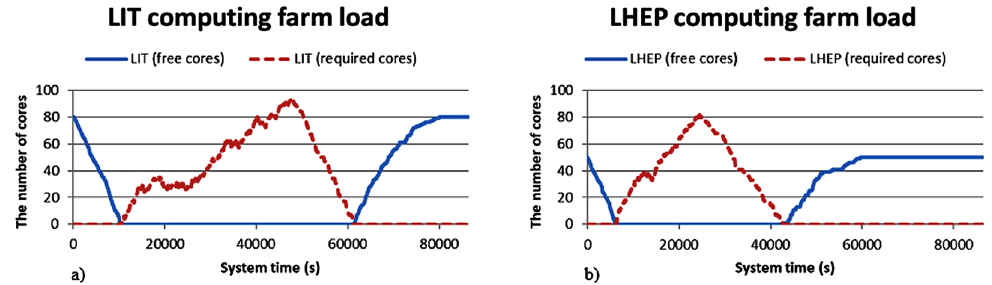
Figure 3. Job queues simulation results (LIT and LHEP computing farms)